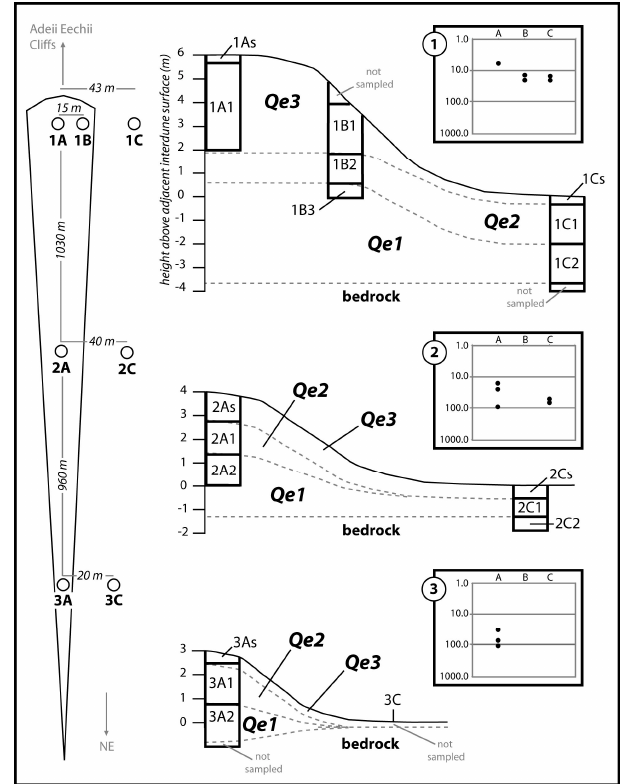
Figure 6. Schematic diagram showing the position of coring locations. Transects are numbered and core locations are lettered. Linear dune crest ( A ) and adjacent interdune ( C ) positions were sampled at all three transects; the side slope position ( B ) was only sampled along the first transect. Cross sections show the location of cores, position of described units (numbered), and inferred correlations and correlated ages. The graphs to the upper right of each cross section plot the ratio of magnetic susceptibility values relative to the value of unweathered Navajo Sandstone for each core.